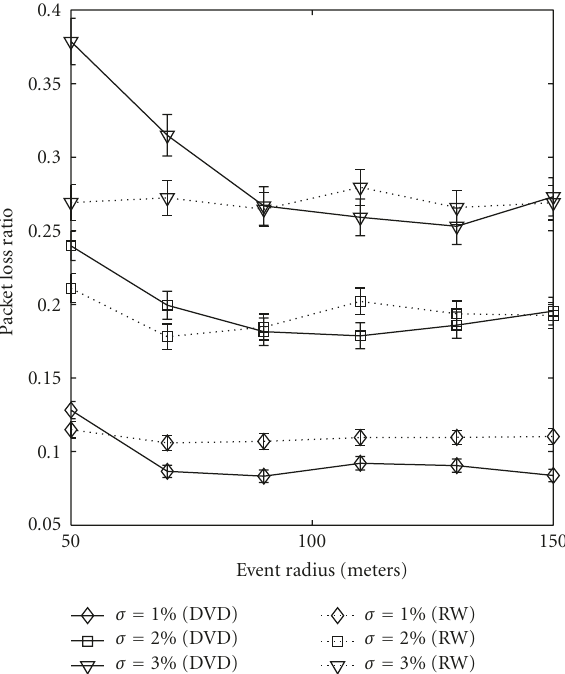
Figure 19: Sensitivity of Center of Event localization error for DVD and RW.